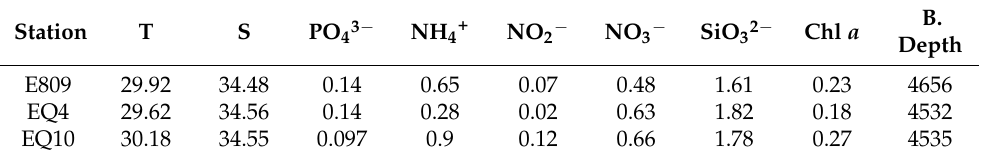
Table 1. Temperature (T, ◦ C), salinity (S), chlorophyll a (Chl a , µ g/L) concentration, bottom depth (B. depth, m), and dissolved inorganic nutrients (ammonium, nitrate, nitrite, phosphate; µ mol/L) in surface water at sampling stations.